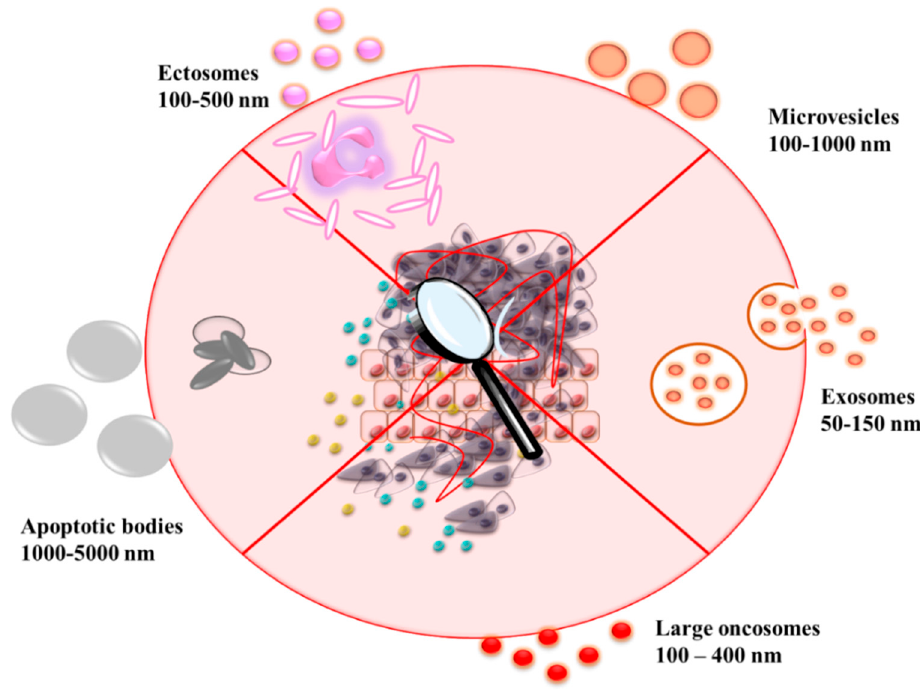
Figure 1. Various types of extracellular vesicles secreted from different cells, normal and tumor respectively.